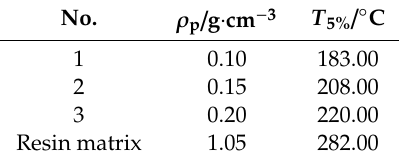
Figure 1. TGA curves of polyurethane composites and resin matrix. Table 3. Decomposition temperature of the composite and the resin matrix.